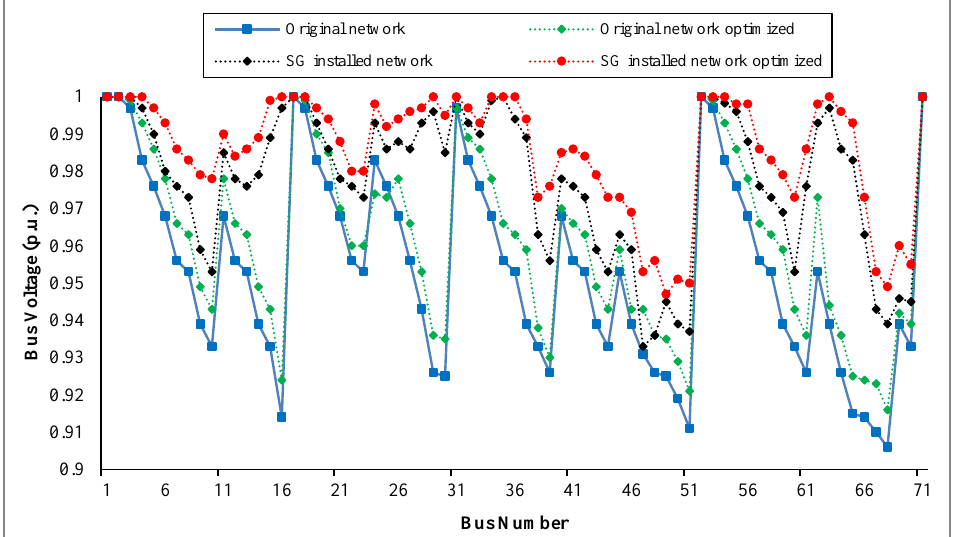
Figure 15. Voltage profile of IEEE model distribution network 71-bus. Table 5. Results of IEEE model distribution network